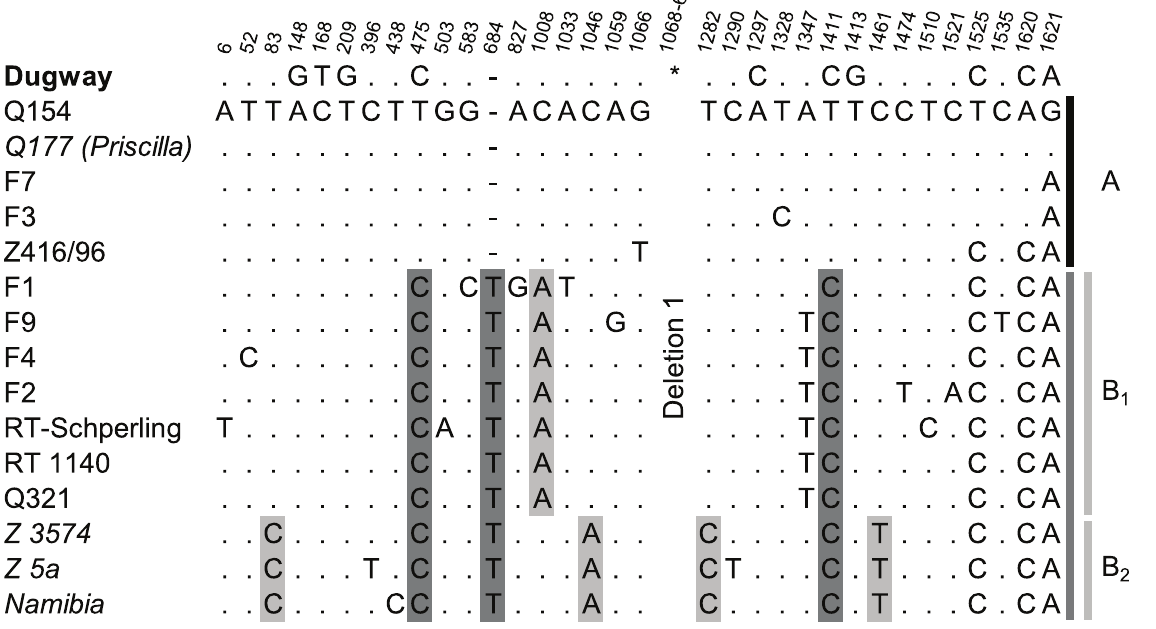
Figure 2. Sequence-based discrimination of the Q154 adaA gene deletion type. This special deletion type is defined by deletion 1 (see Figure 1). Differential bases (SNPs and insertion) of analyzed strains are shown in reference to the published genome of Q154, position 834,296 to 836,007. Vertical numbers display the respective position relative to position in the genome of strain Q154. The large deletion 1 is indicated with an asterix (*). Three conserved distinctions defining the subgroup B are marked in dark grey. The insertion of a ‘T’ is located between position 834,978 and 834,979 of the Q154 genome. Subgroup B can be further divided into two groups B 1 and B 2 (light grey lines) by 5 conserved SNPs (marked light